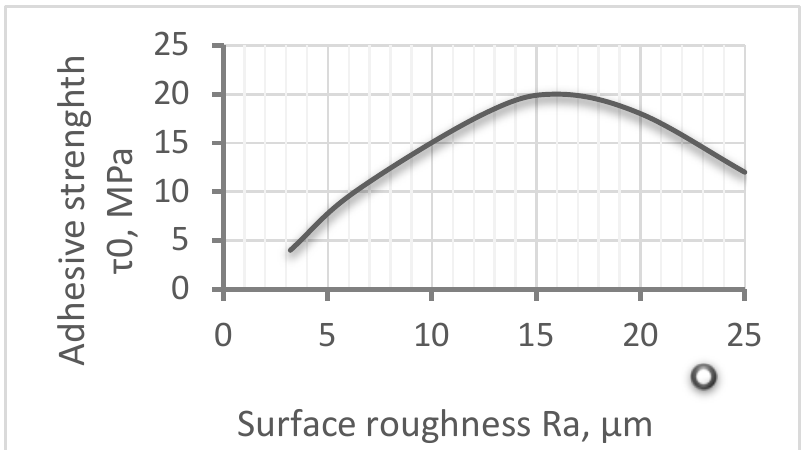
Figure 2. The effect of surface roughness on the adhesive strength of the coating. The graph shows that it is possible to achieve the minimum angle of twist α and, consequently, the maximum adhesion τ 0 by obtaining optimal roughness values Ra , at which the number of peaks will be maximum. The surface roughness Ra recommended by the GOST 9.304-87 standard should be in the range of 6.3–16 µ m ( R z = 25–63 µ m). However, accurate data can only be obtained experimentally. The microstructure of the surface after shot blasting depends primarily on the choice of abrasive particles. As stated above, the adhesion between the substrate and the thermally applied material depends on the roughness of the surface. The resulting microrelief should allow the sprayed material to reliably adhere to the base one. Insufficient roughness will lead to guaranteed delamination of the coating and, con- sequently, excessive need to increase the thickness of the sprayed layer. To prevent